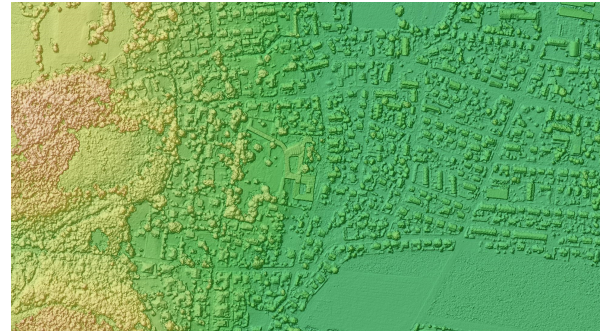
Figure 2. Shaded DSM of